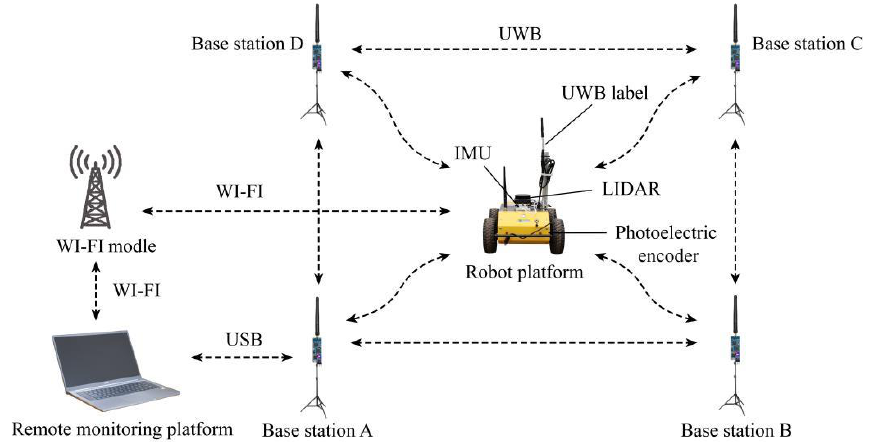
Figure 1. Schematic diagram of the positioning system.